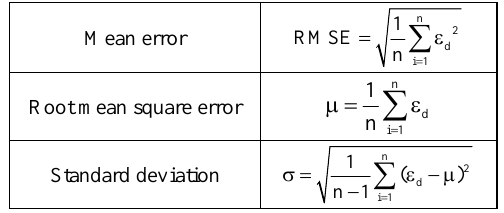
Table 4. Accuracy measures for DEMs presenting normal distribution of errors.